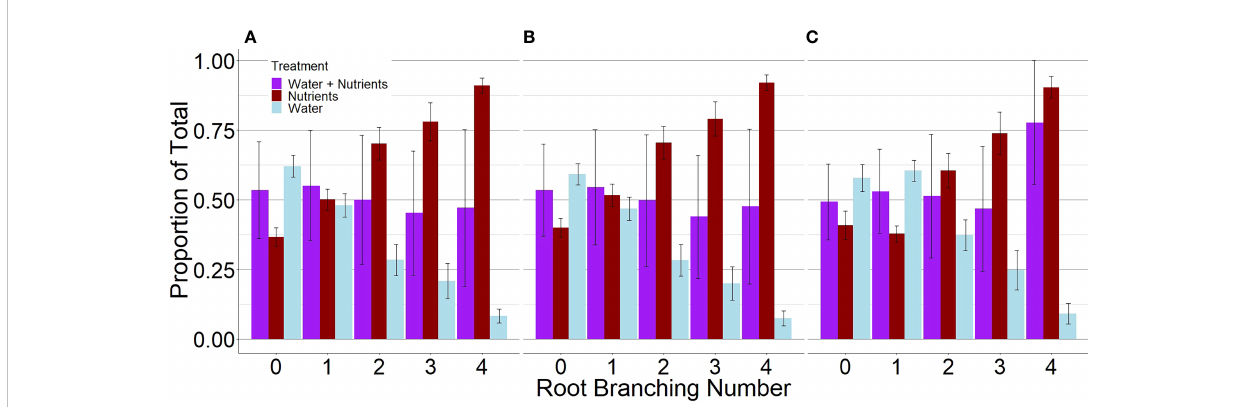
FIGURE 1 Proportions of root length (A) , surface area (B) , and tips (C) of P. virgatum allocated towards each compartment type by root branching number (mean ± SEM). “ Water + Nutrients ” represent split-root compartments in the resource-mixed treatment. To analyze proportions, one split-root compartment was randomly selected from each box. The “ Nutrients ” and “ Water ” represent split-root compartments in the resource-partitioned treatment where water was limited but nutrients were available and where no nutrients were present but water availability was high, respectively. Allocation to higher root branching numbers represent greater lateral root